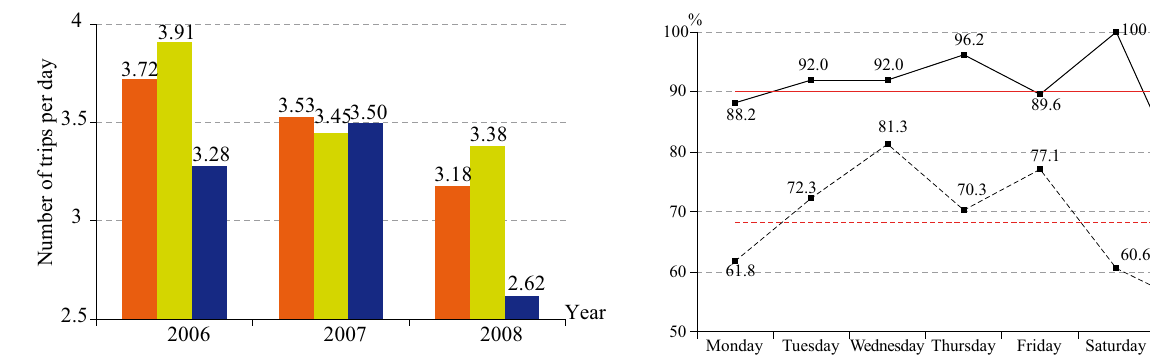
Fig. 5. Physical and virtual mobility during a week – percentage of respondents who made at least one (physical or virtual) trip per day: